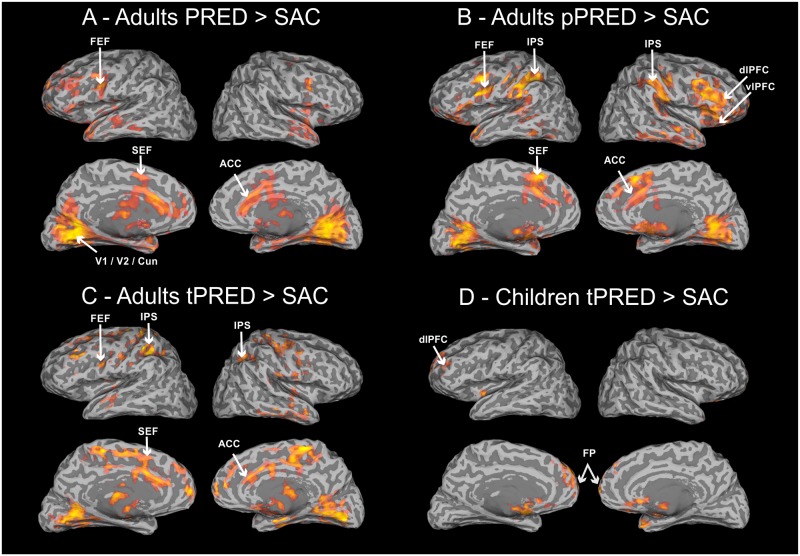
Group activations for tasks with predictable components compared with visually guided saccades.The activation pattern changed according to the tasks predictability. (A) Time/position predictable (PRED) was characterized by an increase in precentral sulcus/superior frontal sulcus and medial frontal lobe. (B) Position predictable (pPRED) the fronto-parietal and anterior cingulate cortex activation was most evident. (C) Time predictable (tPRED) activation was localized mainly in intraparietal sulcus and medial portions of the brain. (D) In children, only time predictable (tPRED) showed differential activation from SAC in frontal cortex. Statistical images were thresholded using cluster determined by Z-score > 1.96 and (corrected) cluster significance threshold of p < 0.05. The MNI coordinates of all activated clusters are described in Supplementary material (S1 Table). (Acronyms: FEF–frontal eye field; SEF—supplementary eye field; ACC–anterior cingulate cortex; IPS—intraparietal sulcus; dlPFC—dorsolateral prefrontal cortex; vlPFC—ventrolateral prefrontal cortex; FP–frontal pole).